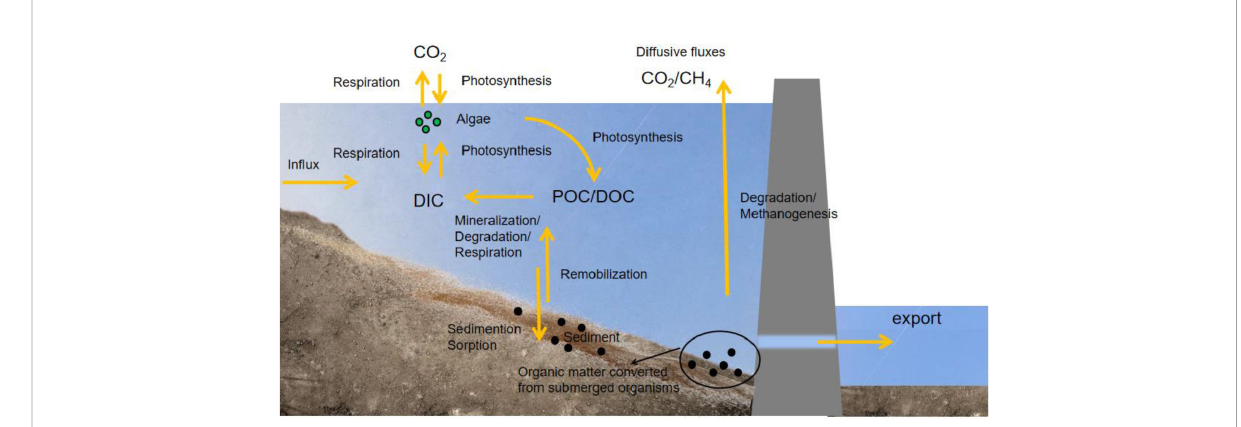
FIGURE 4 Circulation process of carbon in a reservoir. DOC, dissolved organic carbon; POC, particle organic carbon; DIC, dissolved inorganic